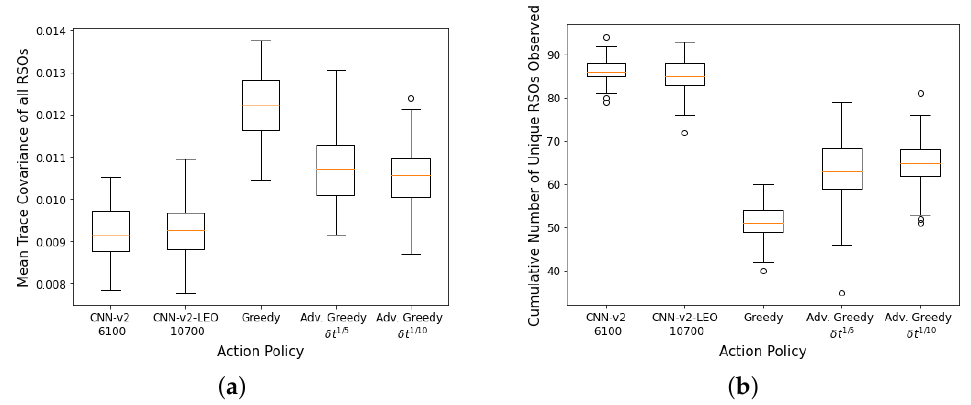
Figure 11. Aggregate performance of selected DRL agents with 100 randomly initialized GEO RSOs, evaluated over 100 seeded rollouts of 90 min each. ( a ) Distribution of the final mean trace covariance at the end of the observation window (lower is better); ( b ) Distribution of the cumulative number of unique RSOs observed at the end of the observation window (higher is better). Note: CNN-v1 3400 represents a CNN-v1 DRL agent trained for 3400 training iterations.